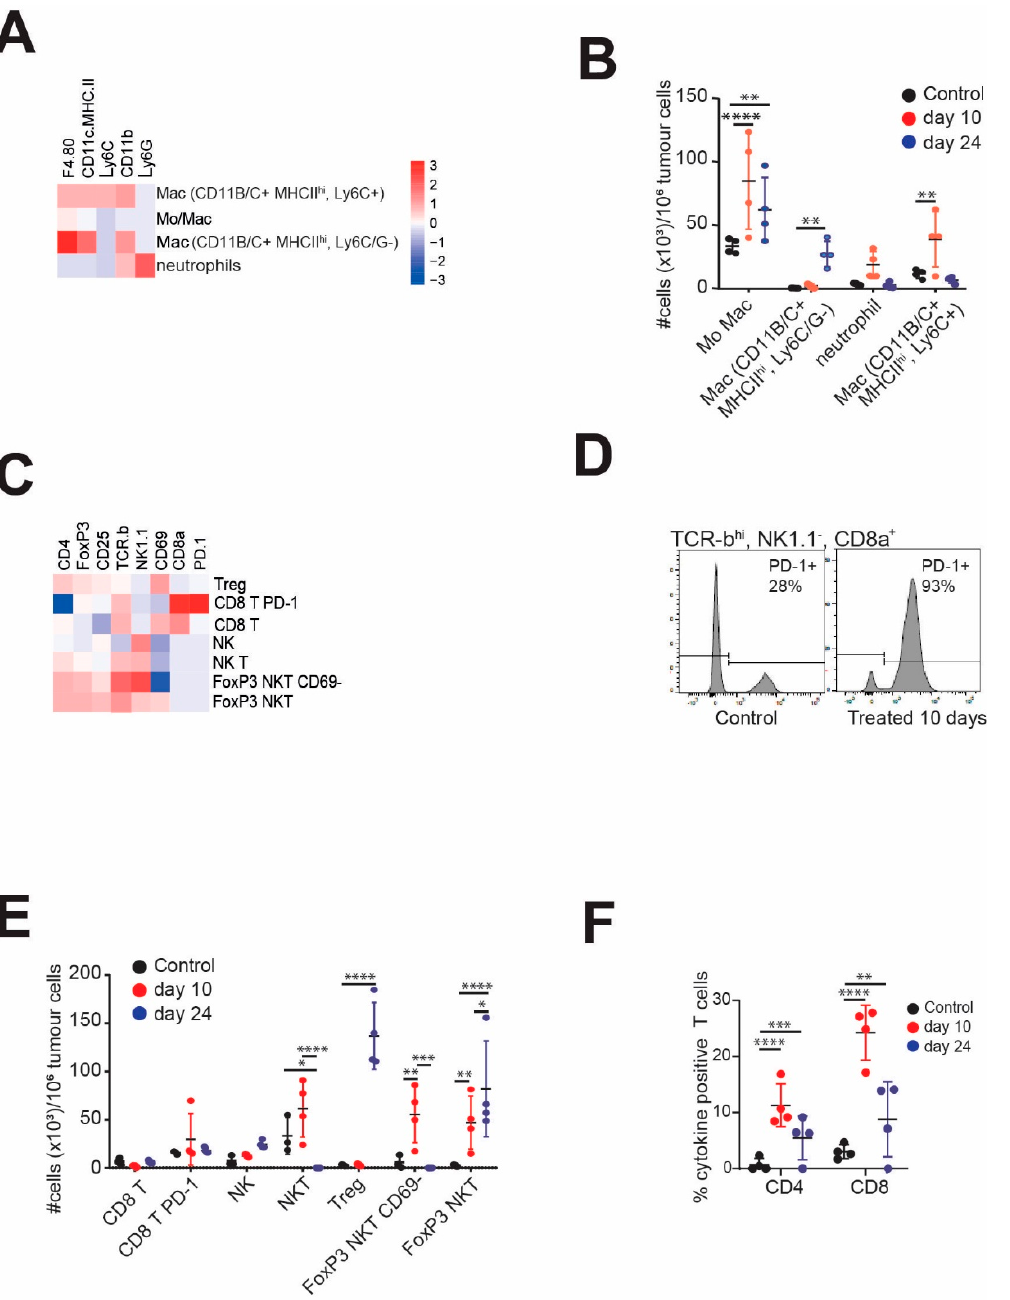
Figure 5. Myeloid and lymphoid cell profiling of YUMMUV1.7 tumours. YUMMUV1.7 tumour bearing mice were treated without or with CHK1i+LDHU for three weeks, three times/week. Untreated controls and treated mice were harvested on day 10 of treatment and treated mice three days after the final treatment (day 24). The tumours were dissociated and the CD45 + population analysed with either six marker panels of myeloid markers, or nine marker lymphoid sets using flow cytometry. Data were subjected to unsupervised clustering of the major clusters for each and quantitated for 4–5 mice for each time point. ( A ). Heatmap of marker staining intensity of major clusters for the myeloid markers and cell types they specify. ( B ). Absolute numbers of each population (per million tumour cells) for the replicate mice. ( C ). Heatmap of marker staining intensity of major clusters for the markers and cell types they specify. ( D ). Typical histogram of PD-1 staining of CD45 + , TCR β hi CD8 α + NK1.1 - (CD8 + T) cells from control and 10 days treated YUMMUV1.7 tumour-bearing mice. ( E ). Absolute numbers of each population (per million tumour cells) for the replicate mice. ( F ). Percentage of tumour antigen-activated cytokine staining T Cells from the blood of the indicated mice at the indicated time points. * p <0.05; **, p<0.01, *** p<0.001, ****p<0.0001.